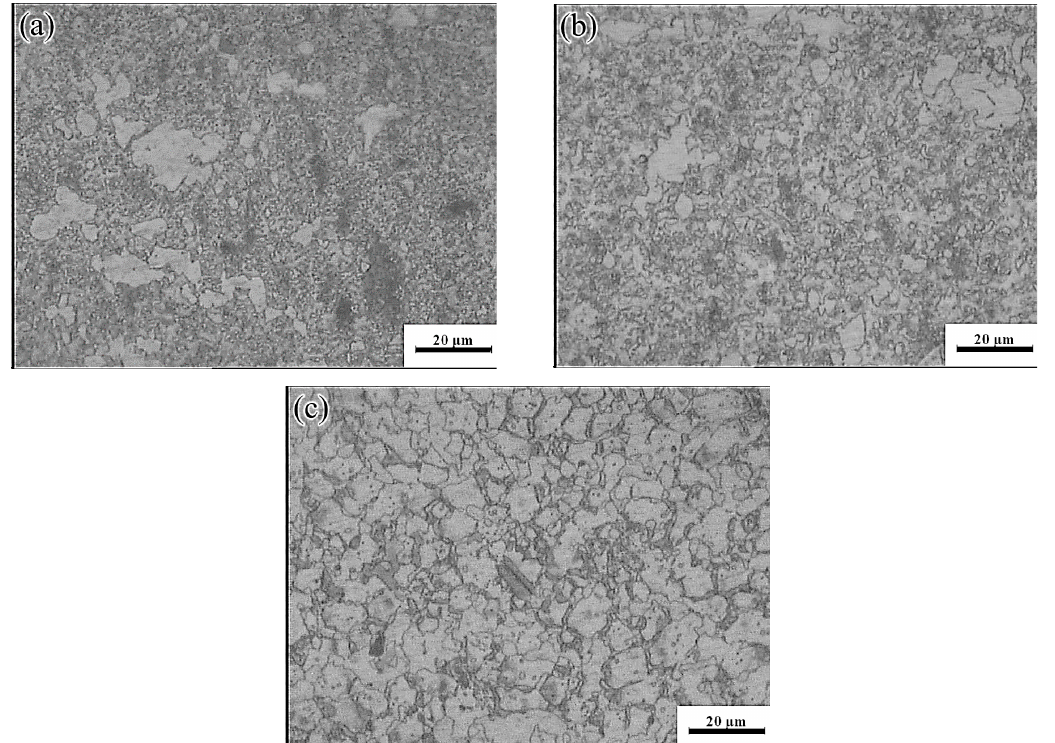
Figure 19. Microstructures of the Mg-16Al Mg alloy in change-over region: ( a ) 573 K / 0 0.01 s − 1 , ( b ) 573 K / 0 0.001 s − 1 , and ( c ) 623 K / 0 0.001 s − 1 .